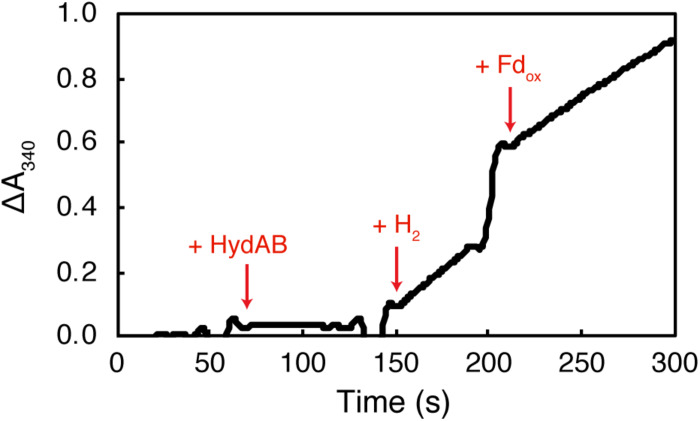
The reduction of NAD+ by HydAB is not ferredoxin dependent. Purified recombinant HydAB (8.1 μg) was added to assays as denoted by + HydAB. The reaction was initiated with the addition of H2. Clostridial ferredoxin was added at a concentration of 10 μM as indicated by + Fdox. The rate of reduction of NAD+ (ΔA340) after the addition of H2 (0.275 ΔA ⋅ min–1) was similar to the change after the addition of clostridial ferredoxin (0.23 ΔA ⋅ min–1).